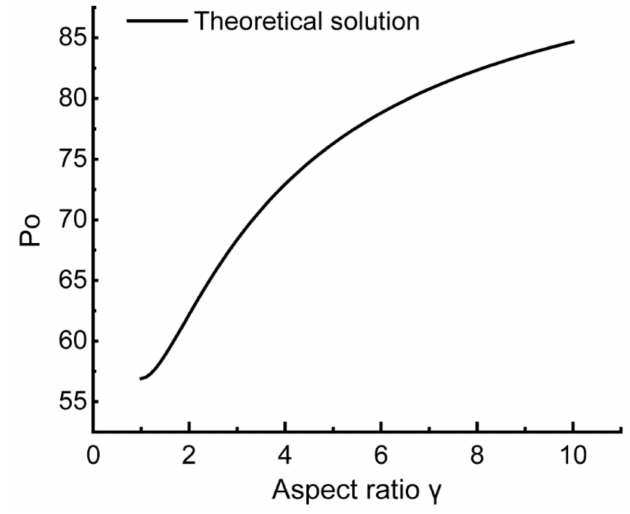
Figure 5. Variation of Po in rectangular channel with aspect ratio γ . Table 2. Comparison between the physical and numerical results. Aspect Ratio